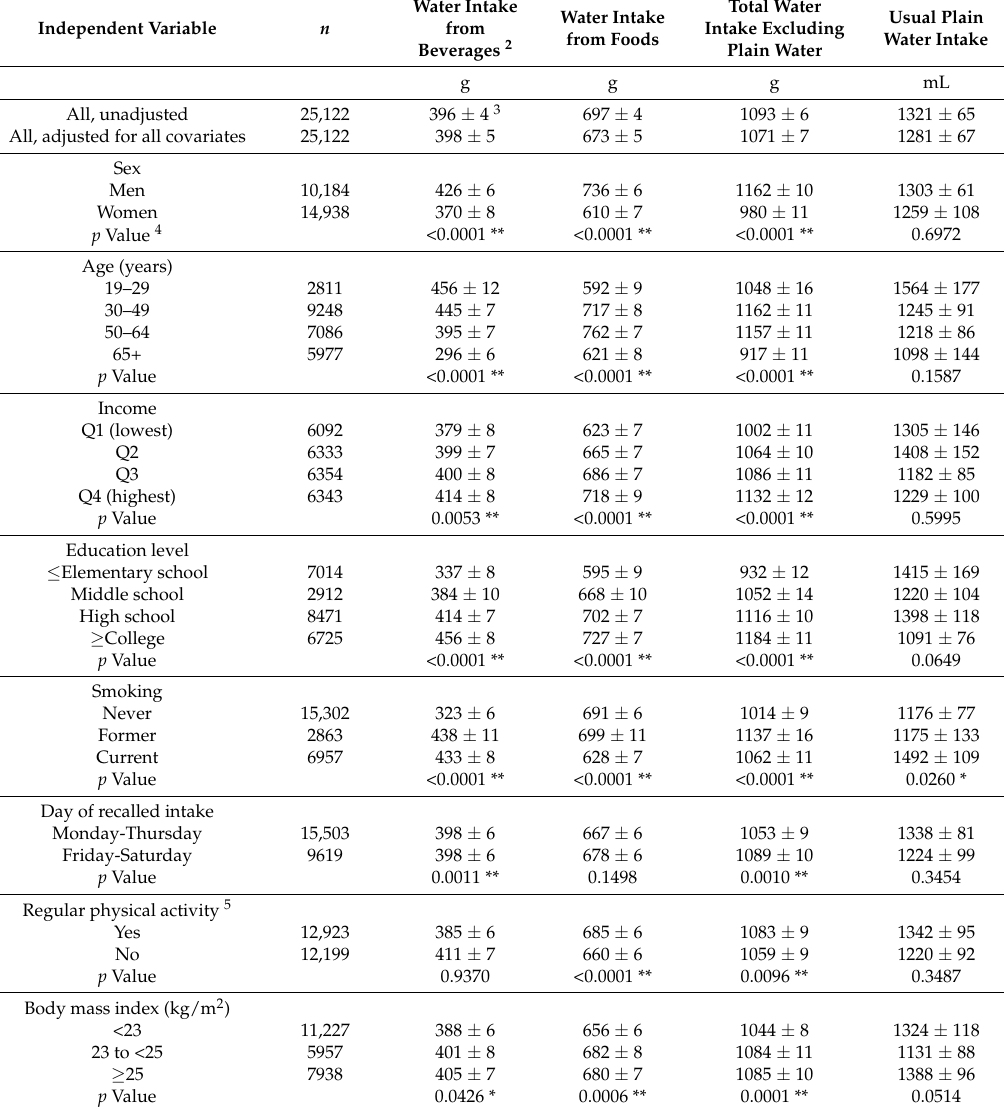
Table 1. Water intake by sociodemographic and health-related behaviors in Korean adults, KNHANES 2008–2012 1